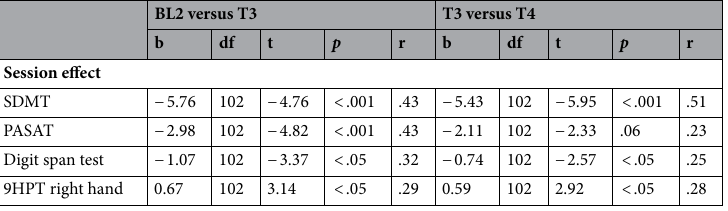
Table 3. Significant contrasts of linear models for session effect between BL2 versus T3 and T3 versus T4. SDMT, symbol digit modalities test; PASAT, paced auditory serial addition test; 9HPT, nine hole peg